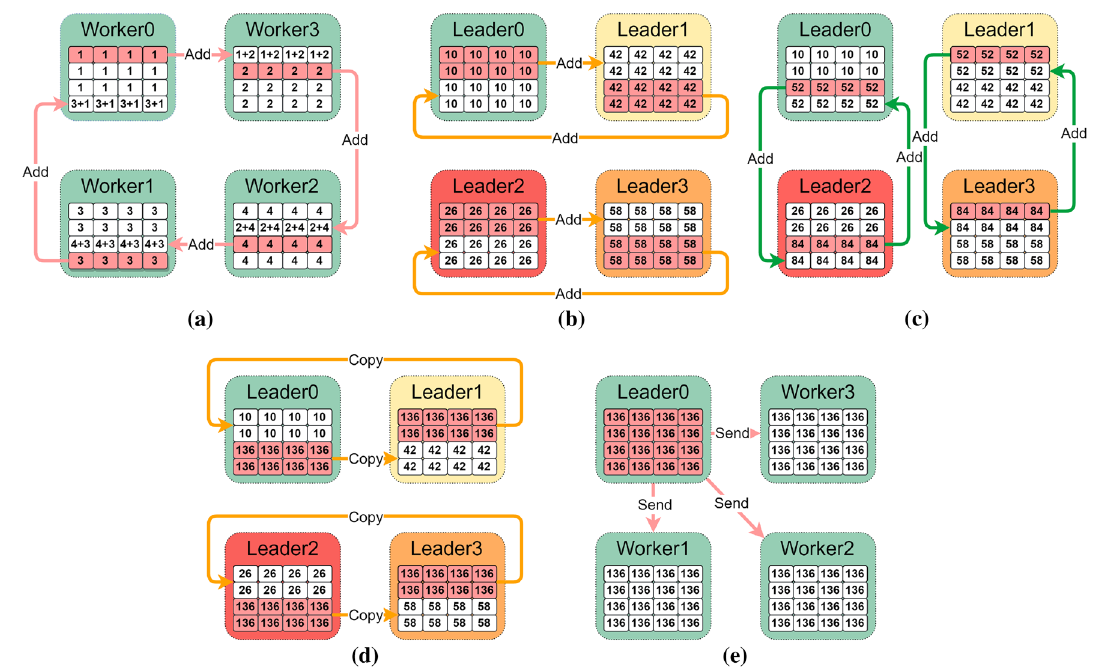
Fig. 2 2D-TGA algorithmic diagram with sixteen workers. a The first group performs the Ring AllReduce. b Establish Cartesian topology for four leaders and perform Reduce-Scatter operation horizontally. c